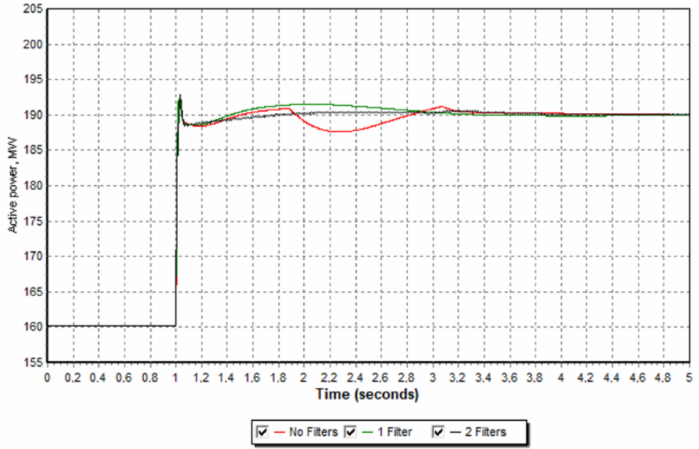
Figure 10. Influence of filters on the active power transfer of the HVDC BtB